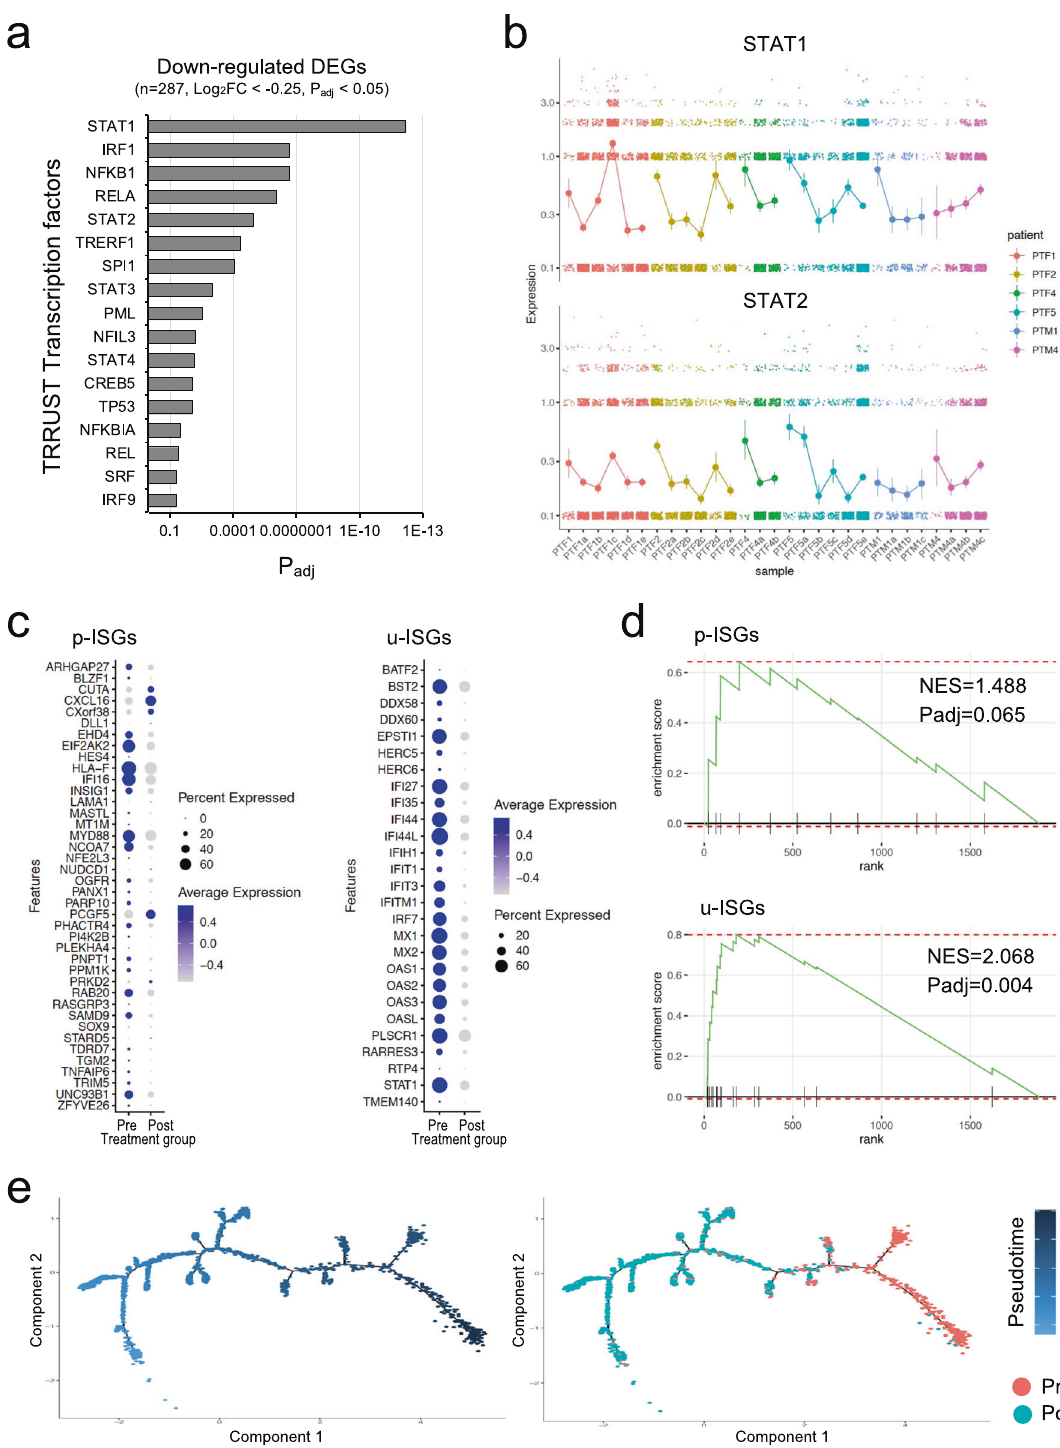
Fig. 4 Corticosteroid treatment downregulates the prolonged expression of u-ISGs via STAT1 in classical monocytes (CMs) and intermediate monocytes (IMs). a Gene set enrichment analysis of TRRUST transcription factors for genes downregulated by corticosteroid treatment. Padj, adjusted P value. b Expression of STAT1 and STAT2 in longitudinal samples obtained during the course of corticosteroid treatment. Colors represent individual patients. Error bars indicate the SD. c Dot plots showing p-ISGs and u-ISGs changed between pre- and post-corticosteroid treatment. Dot size indicates the percentage of cells in which the gene was detected ( “ Percent Expressed ” ). Color indicates the average expression level of the gene (scaled data) in each cluster ( “ Average Expression ” ). d Gene set enrichment analysis of p-ISGs and u-ISGs changed between pre- and post-corticosteroid treatment. NES, normalized enrichment score; Padj, adjusted P value. e Trajectory plots for CMs/IMs from samples collected pre- and post-corticosteroid treatment. Cells were ordered by the expression of u-ISGs. Colors represent pseudotime (left) or samples